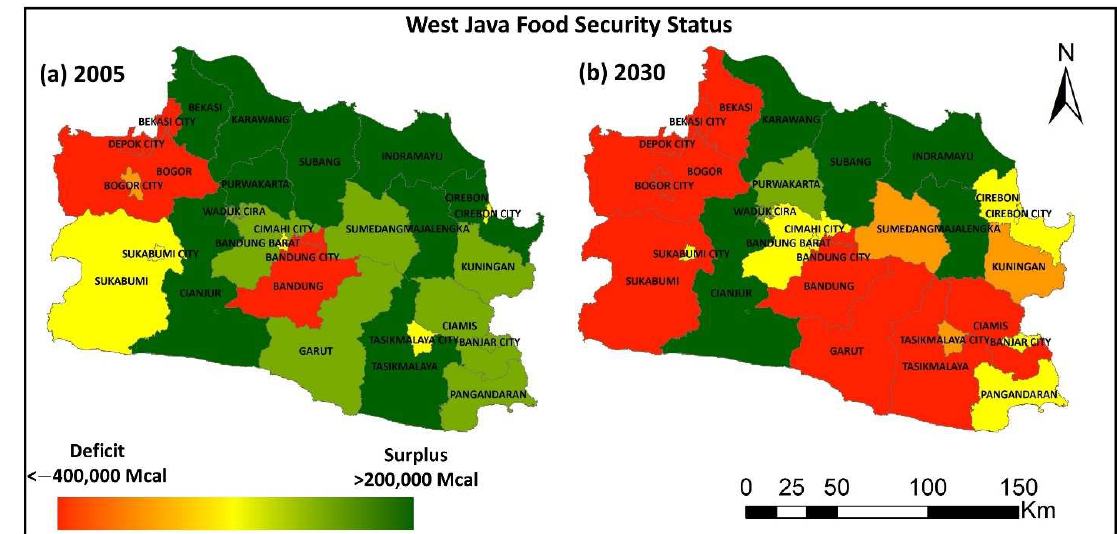
Figure 8. Food (carbohydrate) status in West Java ( a ) in 2005 and ( b ) the predictions in 2030.